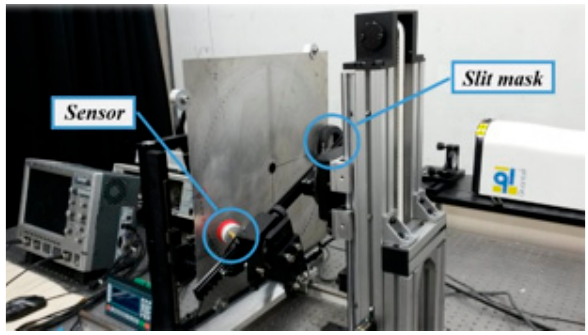
Figure 19. The actual experimental platform.